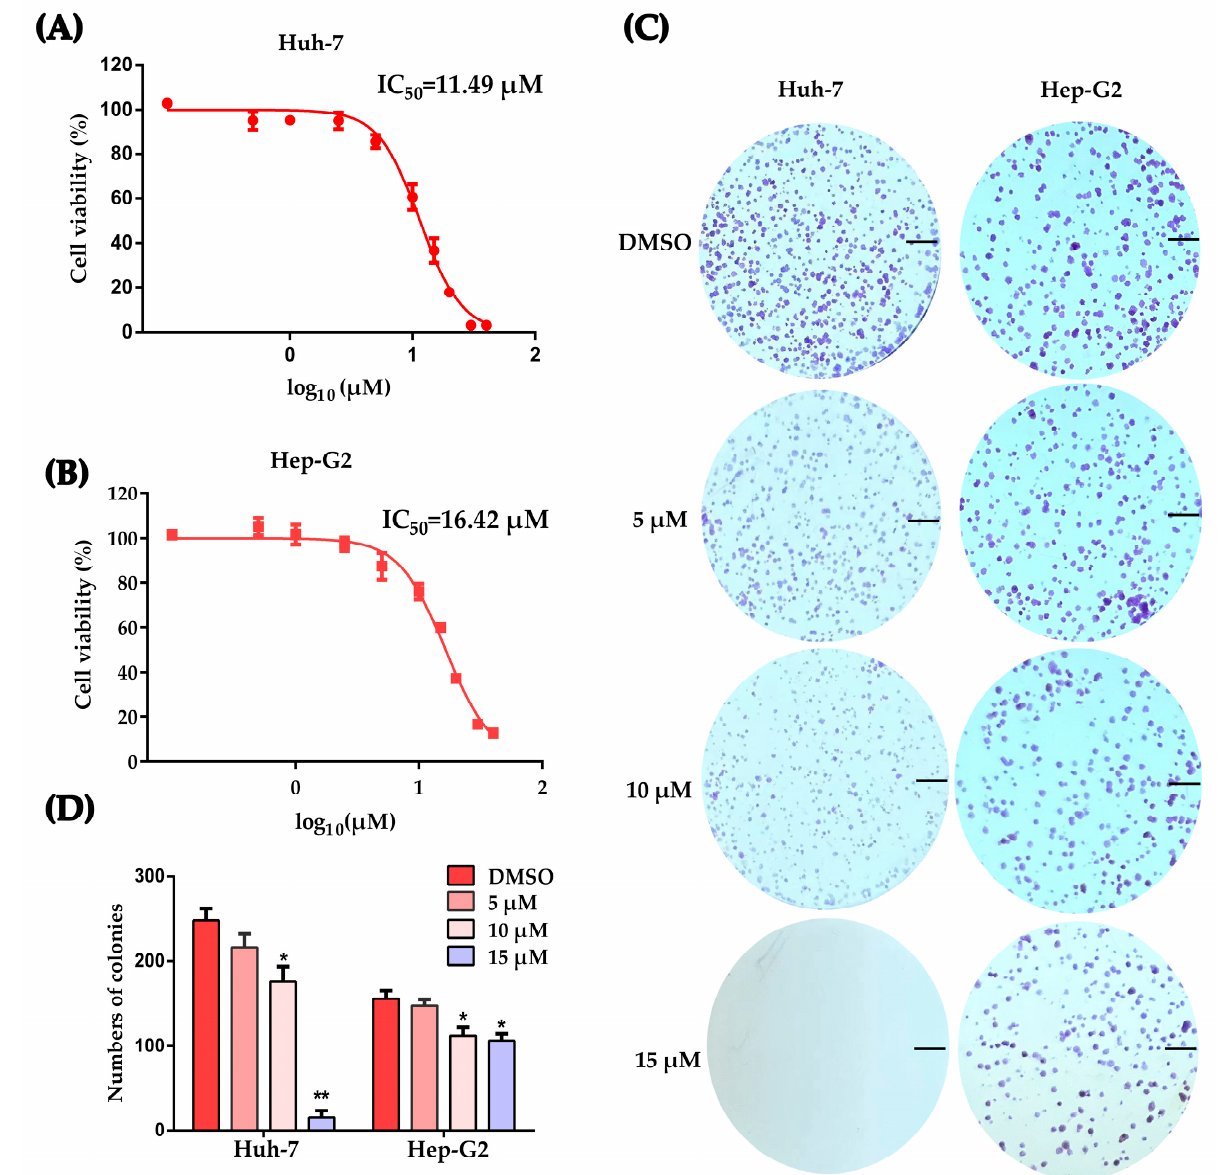
Figure 1. Determining the working concentration of plumbagin on HCC cells. ( A , B ) Huh-7 and Hep- − G2 cells were treated with plumbagin at concentrations of 0.1~40 µ M for 12 h. Cell viability was tested by CCK-8 kit. Three replicates were set for this test and three independent experiments were performed. The data are shown as the mean ± SD. ( C , D ) Representative plates with colony formation assay, scale bar = 5 mm. Results are expressed as the numbers of counted colonies and compared to the DMSO group using t -test, * p < 0.05, ** p < 0.01 compared to the DMSO group. 2.2. Plumbagin Induces G2/M Cell Cycle Arrest of HCC Cells Huh-7 and Hep-G2 cells were treated by plumbagin at the determined concentrations for 12 h and collected for analysis by flow cytometry. The results in Figure 2A demonstrated that plumbagin significantly induced G2/M cell cycle arrest. Meanwhile, cells at the G0/G1 stage were significantly decreased (Figure